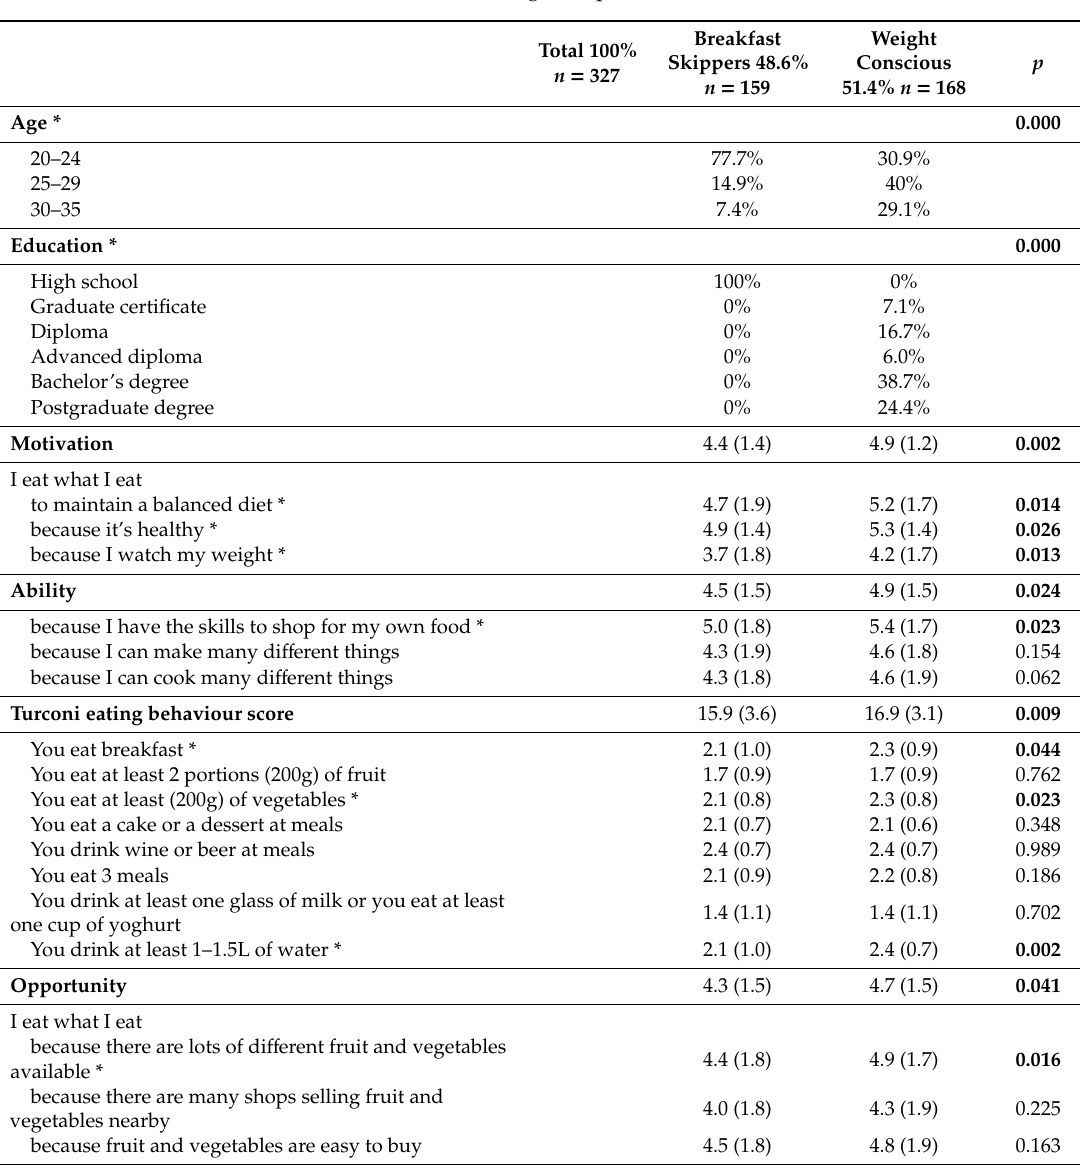
Table 2. Segment